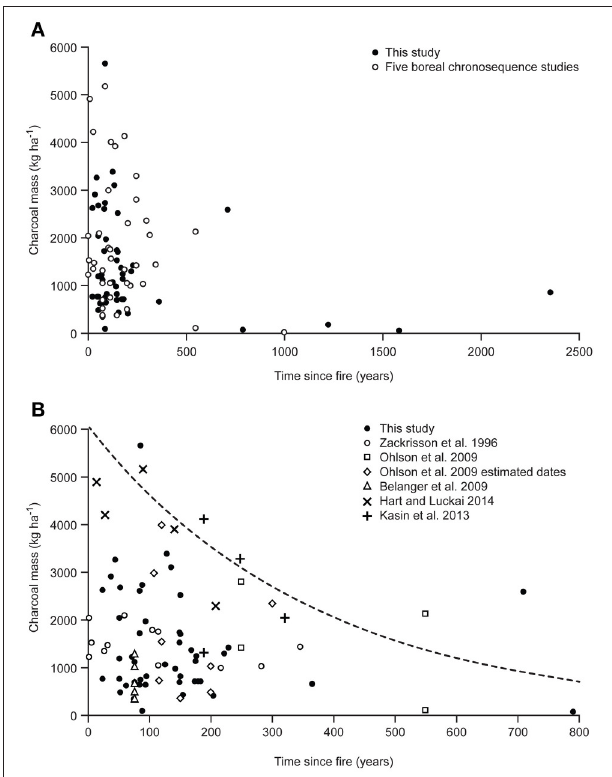
FIGURE 6 | Charcoal stocks (kg ha − 1 ) for this study compared with data from five studies of mainly boreal, coniferous forest sites (A) . The expansion (B) shows data from individual studies up to 800 ysf. The outer envelope of the data cloud (dashed line) was defined by selecting the 5% highest charcoal mass values for each 100-yr classes (up to 399 ysf: 0–99, 100–199, 200–299, and 300–399 ysf), and passing a logarithmic regression curve through these data points ( R 2 : 0.80). Sources for (A) as shown in (B) plus pers. comm. from Stephen